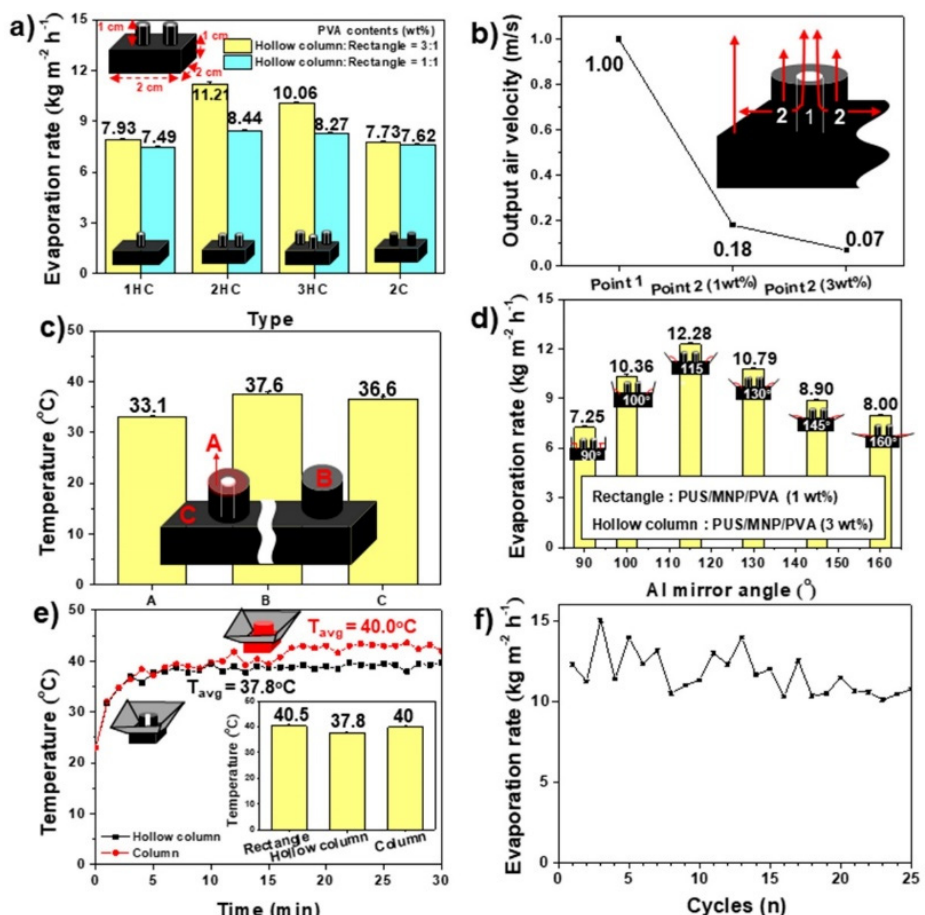
Figure 4. ( a ) Toluene evaporation rates for the RPSs with different numbers of hollow columns (n: 1–3). The RPS samples consisted of rectangular structures [PUS/MNP/PVA (1 wt%)] and hollow columns [PUS/MNP/PVA (1 wt% and 3 wt%)]. ( b ) Output air velocity and ( c ) surface